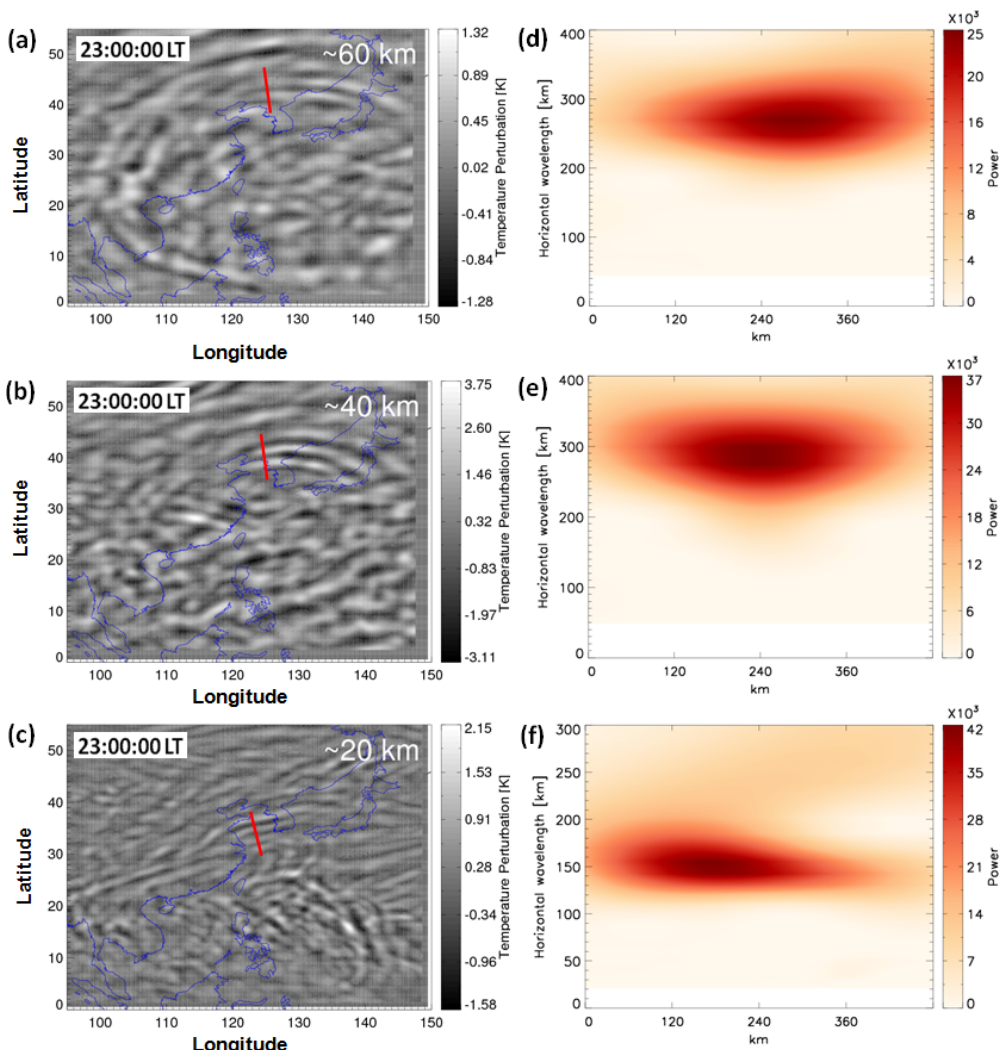
Figure 4. Temperature perturbations at (a) ∼ 60km, (b) ∼ 40km, and (c) ∼ 20km at 23:00LT on 4 October 2016 derived from ERA5 reanalysis. (d) Wavelet power spectrum along the red line in (a) , (e) wavelet power spectrum along the red line in (b) , and (f) wavelet power spectrum along the red line in (c)